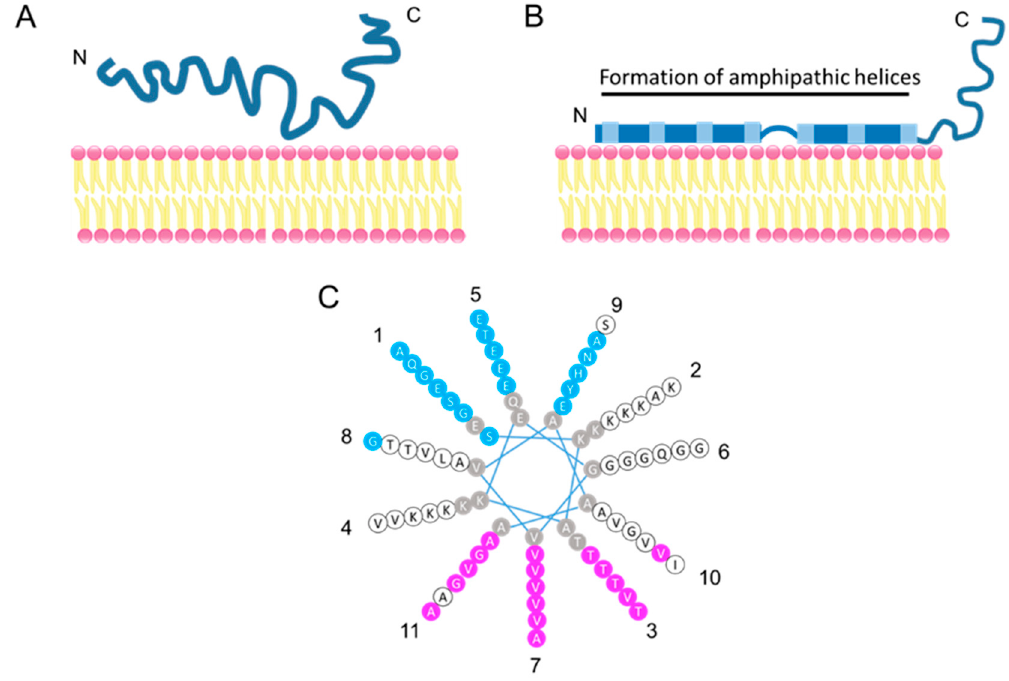
Figure 2. Model of membrane-bound α -syn. ( A ) Natively unfolded α -syn in solution. ( B ) Membrane-bound α -syn. The N-terminal region of α -syn folds into an amphipathic helical structure upon membrane contract. ( C ) The helical wheel model of the α -syn repeated region (9–89 aa). Residues in pink are hydrophobic and buried inside membranes when α -syn binds to membranes, residues in blue are exposed to the hydrophilic side (i.e., the cytoplasm), residues in white are on neither the membrane-exposed side nor on the solvent-exposed side, and residues in gray are not tested by continuous-wave electron paramagnetic resonance [53]. Eleven repeated lysine residues contribute to hydrogen bonding with acidic phospholipids. Numbers around the helical wheel indicate a repeat position. Adapted from [53] .